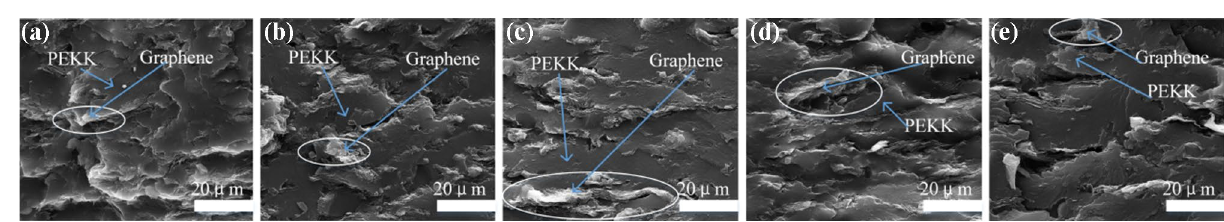
Figure 8. SEM analysis for the different graphene content composite sheets: ( a ) 3%; ( b ) 4%; ( c ) 4.5%; ( d ) 5%; ( e ) 6% (Visio 2021, Prof. WenPing.